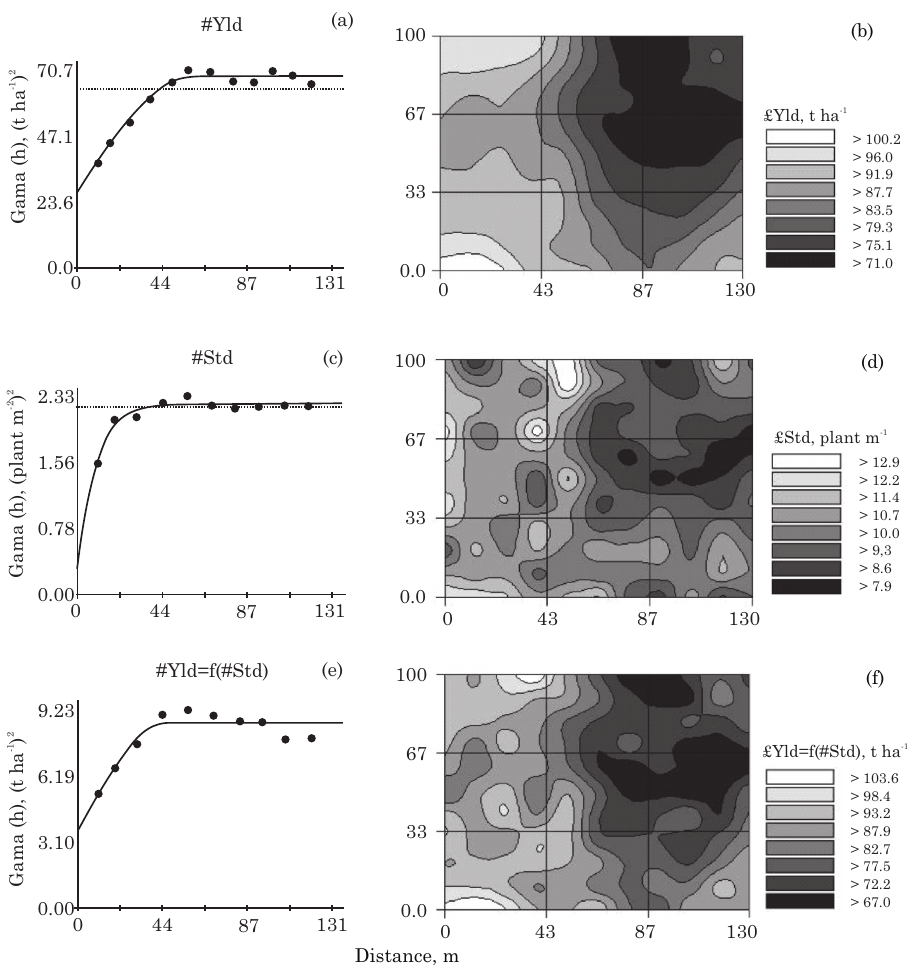
Figure 3. Single and cross-semivariogram, and maps cokriging of sugarcane properties in an eutrophic Ultisol, in the treatment in which the trash was removed from the